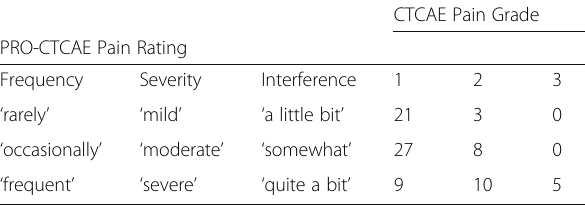
Table 3 Distribution of Raw CTCAE Ratings when